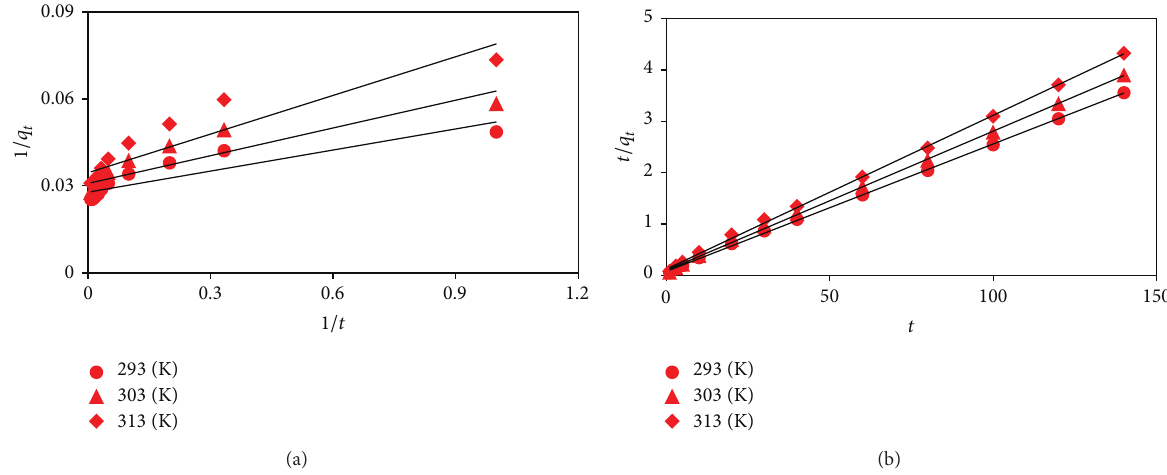
Figure 4: Plots for pseudo-first-order (a) and pseudo-second-order (b) kinetic models.